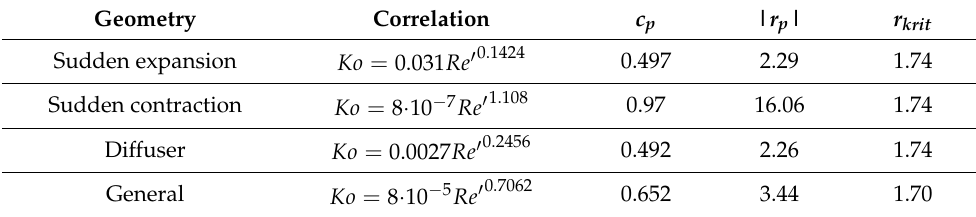
Table 5. Parameters of developed correlations.